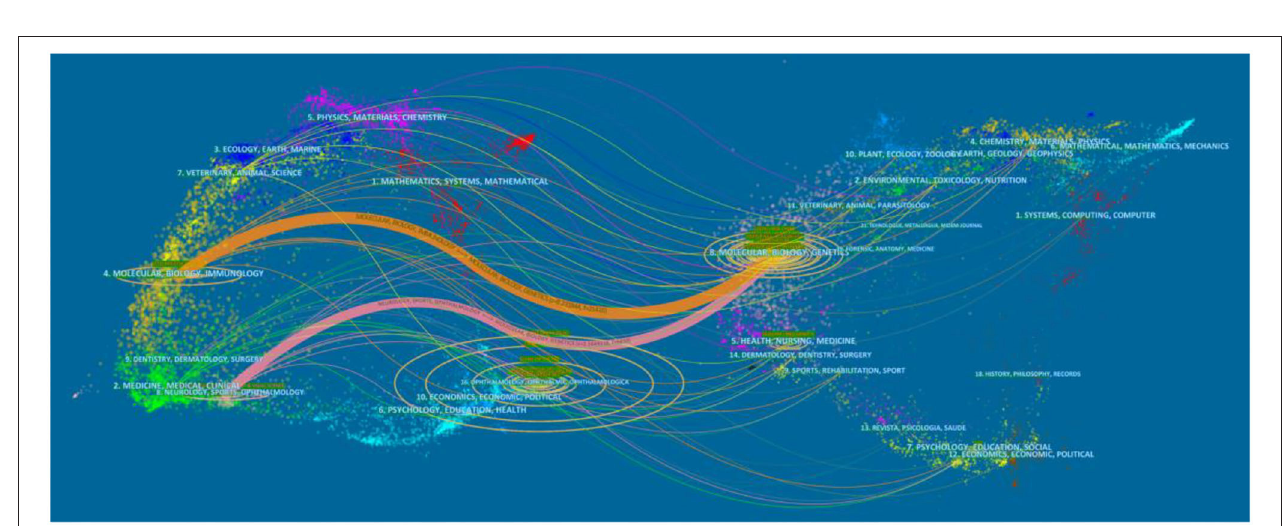
FIGURE 6 | The dual-map overlay of journals contributed to publications on Cataract-gene from 2010 to 2019.